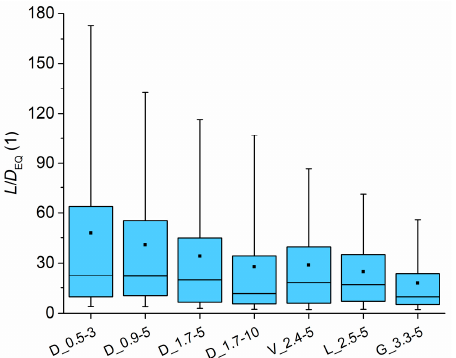
Figure 3. Estimated distribution of fibre aspect ratio in the